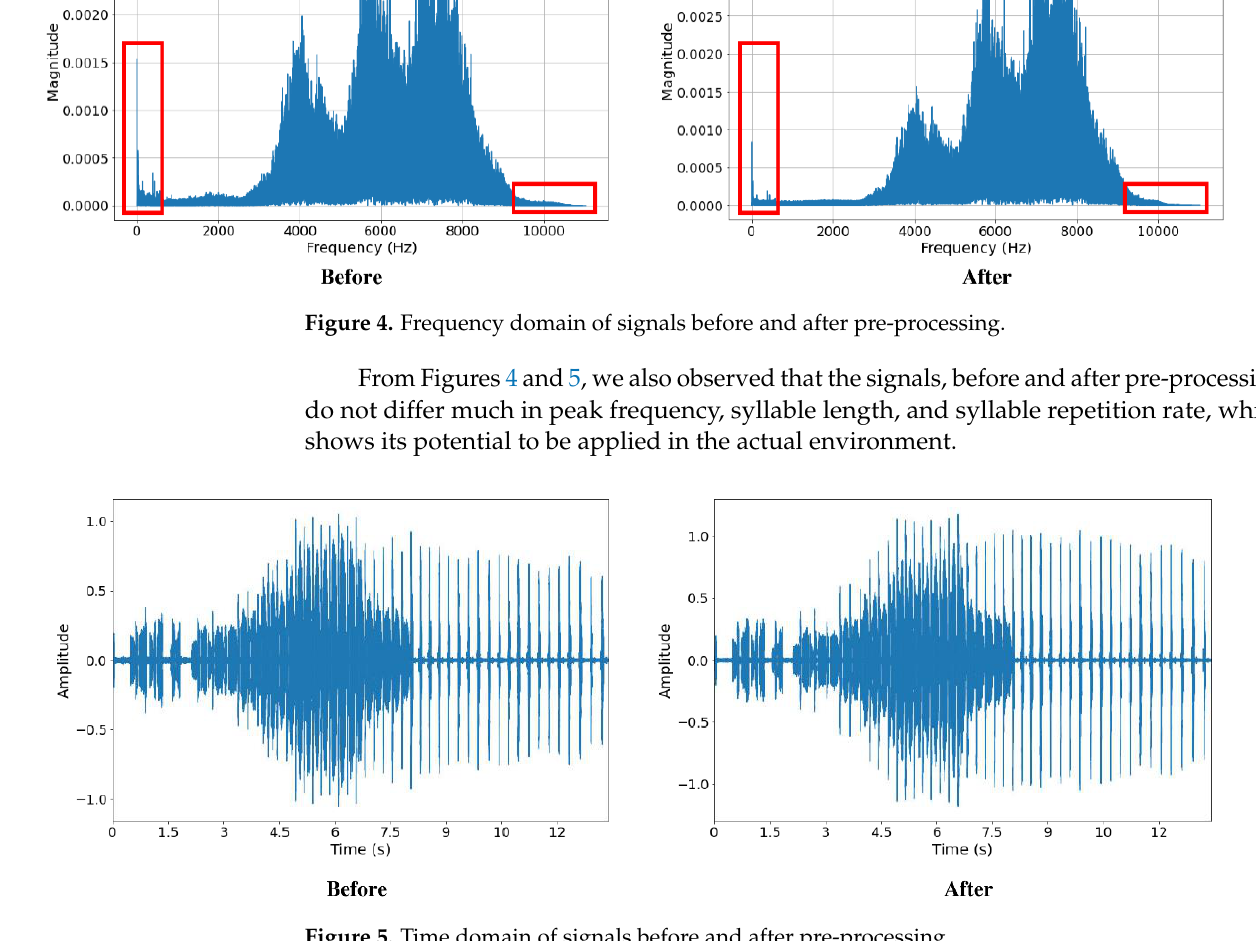
Figure 6. Flowchart of the Härmä syllable segmentation algorithm. The output of each step involved in the Härmä algorithm is shown in Figure 7. The spectrogram images are for illustration purposes only. Only one spectrogram image will be generated upon complete execution of the algorithm.